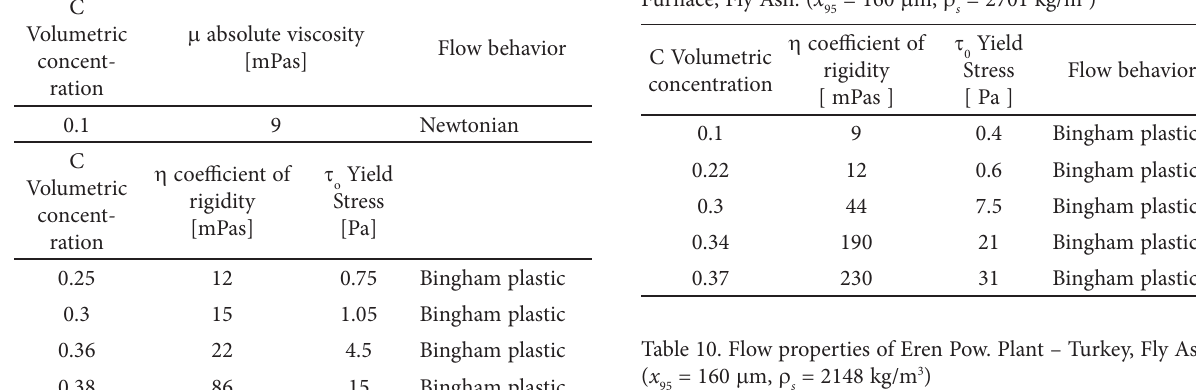
Table 9. Flow properties of Narva Pow. Plant N°8. Balti CFB